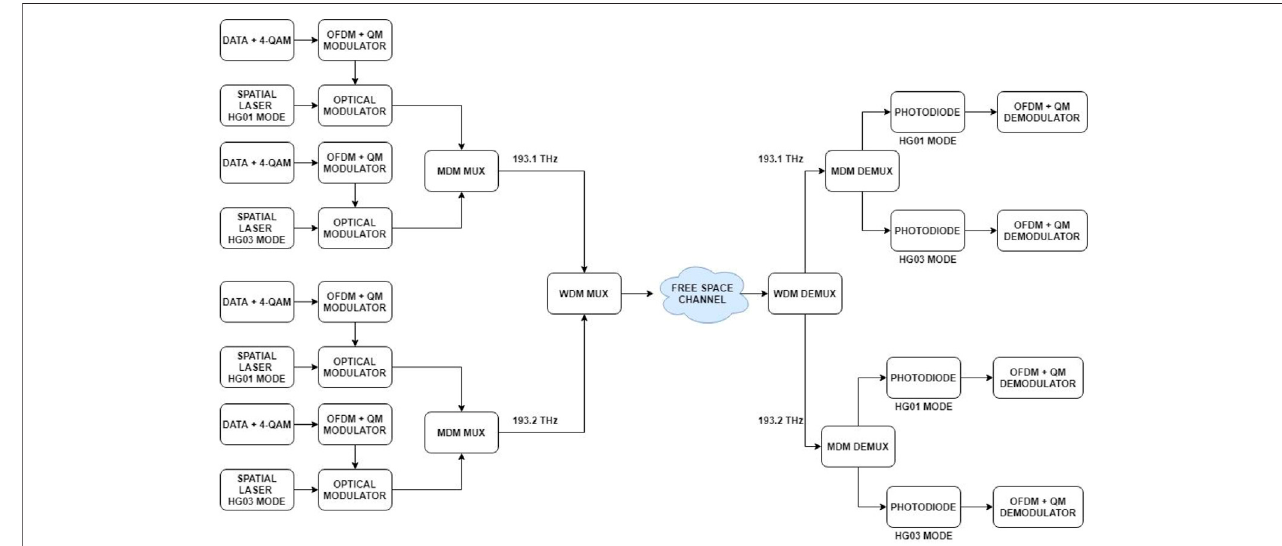
FIGURE 1 | Schematic design of the proposed link.